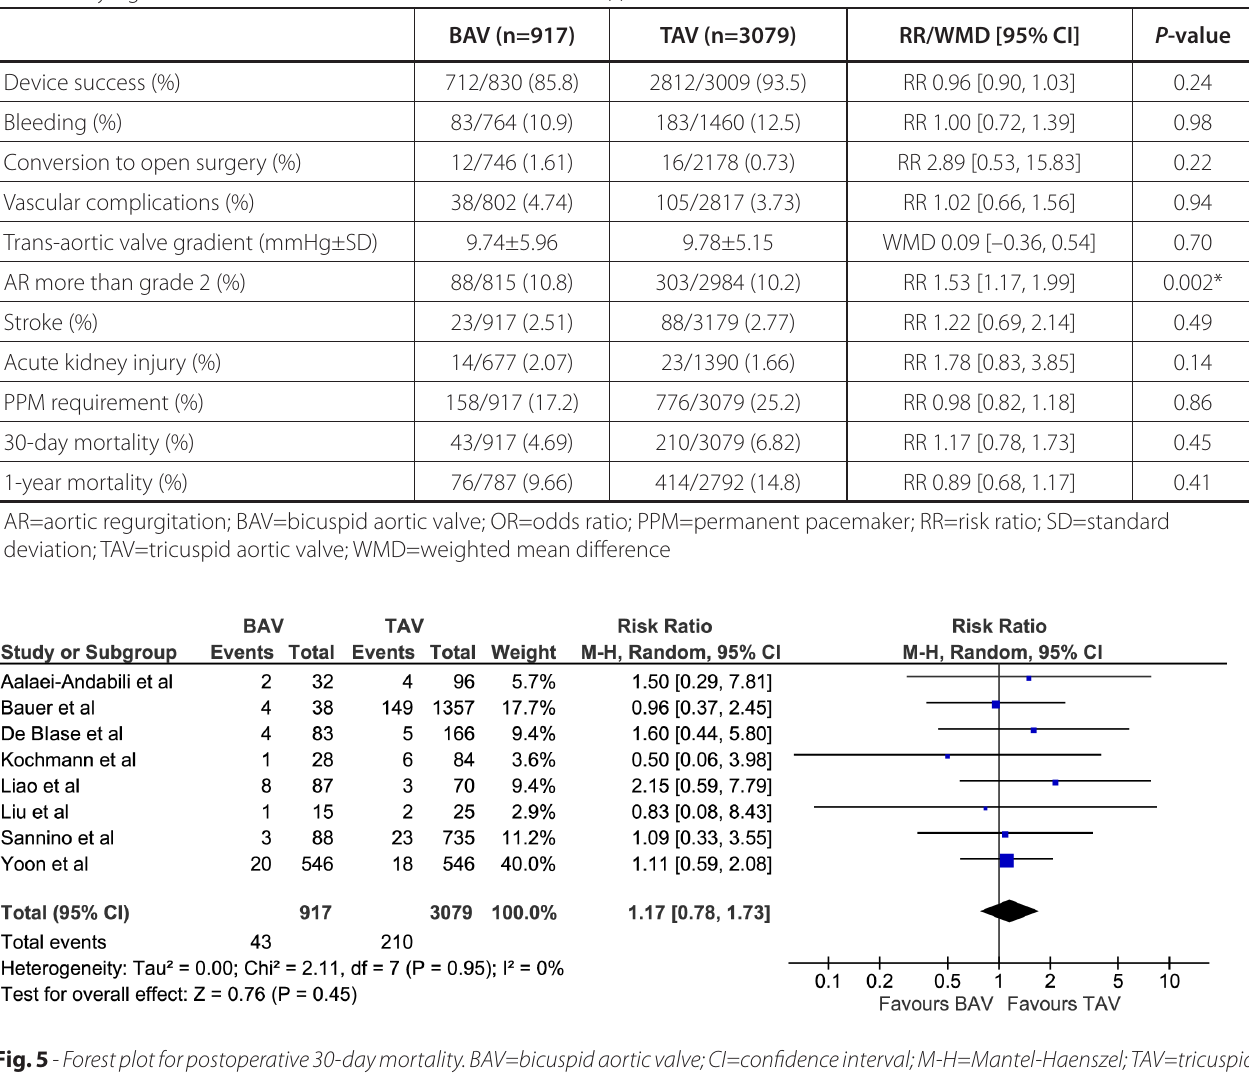
Fig. 5 - Forest plot for postoperative 30-day mortality. BAV=bicuspid aortic valve; CI=confidence interval; M-H=Mantel-Haenszel; TAV=tricuspid aortic valve